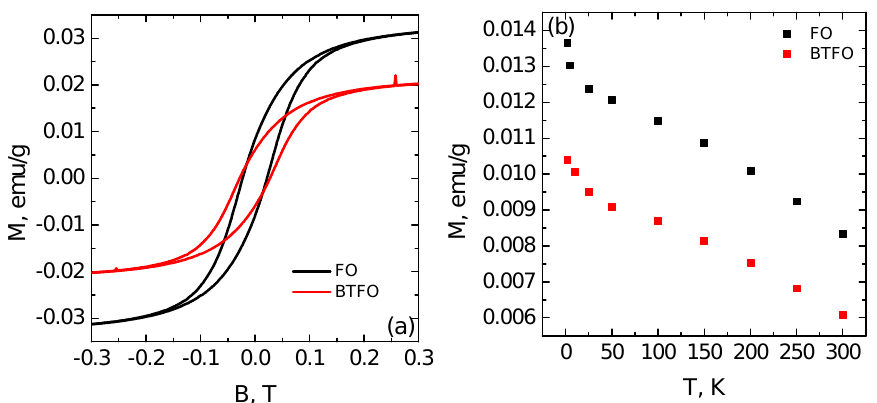
Figure 3. Magnetic hysteresis loops of the BTFO and FO samples ( a ). The temperature dependence of the remnant magnetization ( b ).